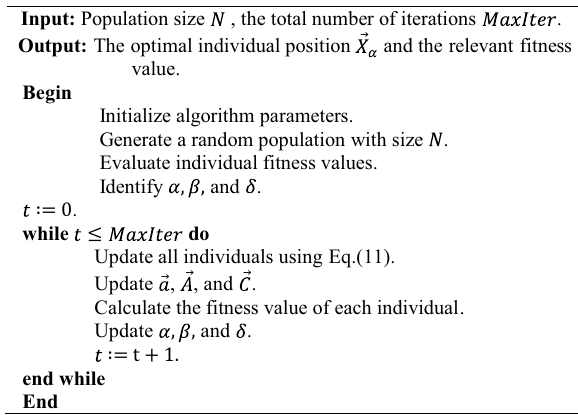
Algorithm 1 Pseudocode of the GWO algorithm.